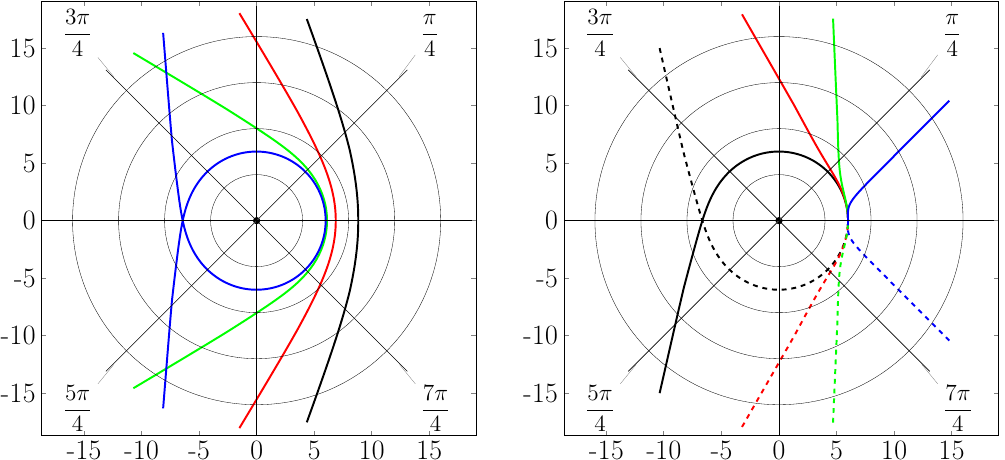
Figure 6. Photon trajectories of massive test particles for ansatz (28) with a = 9. In the left plot: b = 10 (black line), b = 8 (red line), b 7 (green line), b = 6.7 (blue line). In the right plot: b = 6.65 (black line), b = 6 (red line), b = 5.3 (green line), b = 3 (blue line). The dashed parts of lines represent the parts of trajectories located in the region r <